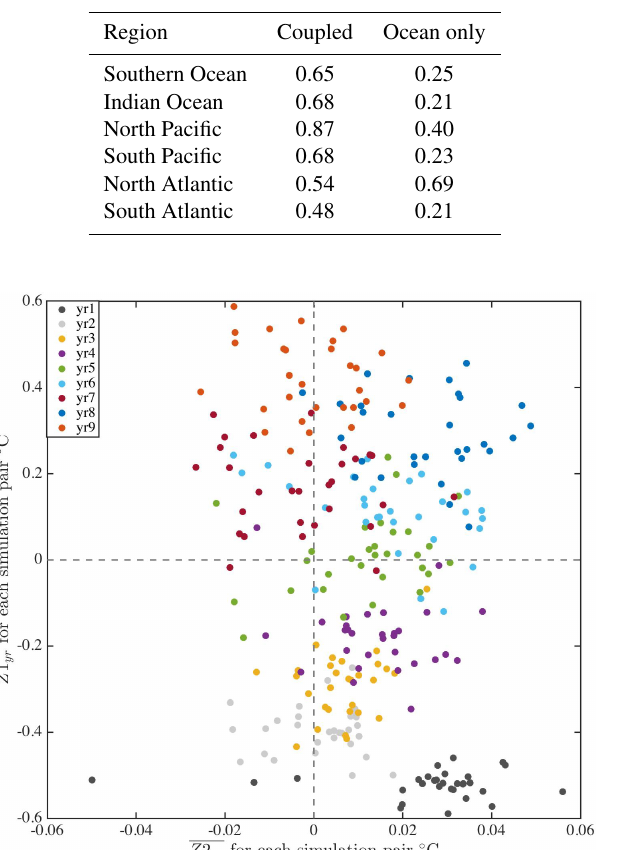
Table 2. Regional uncertainty values (2 σ ◦ C).